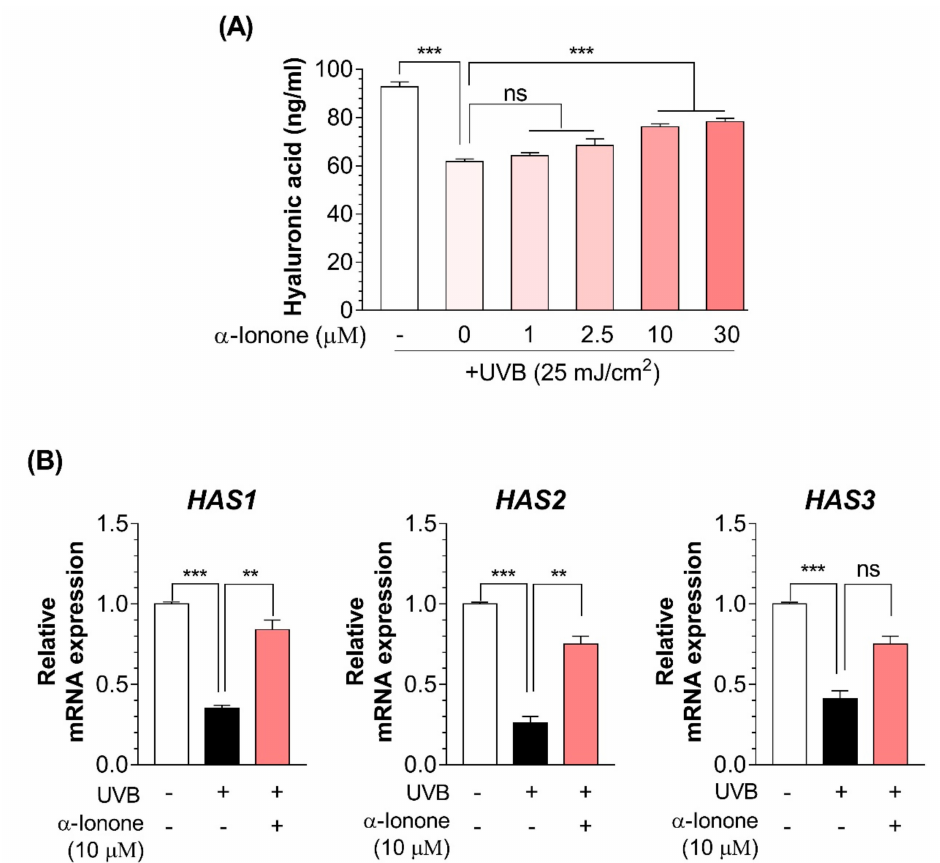
Figure 5. α -Ionone increases hyaluronic acid (HA) contents in human Hs68 dermal fibroblasts. ( A ) HA contents. ( B ) mRNA expression levels of genes related to HA synthesis in Hs68 cells. Values are presented as means ± SEM (n = 3). Significant di ff erences between groups are indicated by asterisks: ** P < 0.01; *** P < 0.001; ns, not significant ( P >